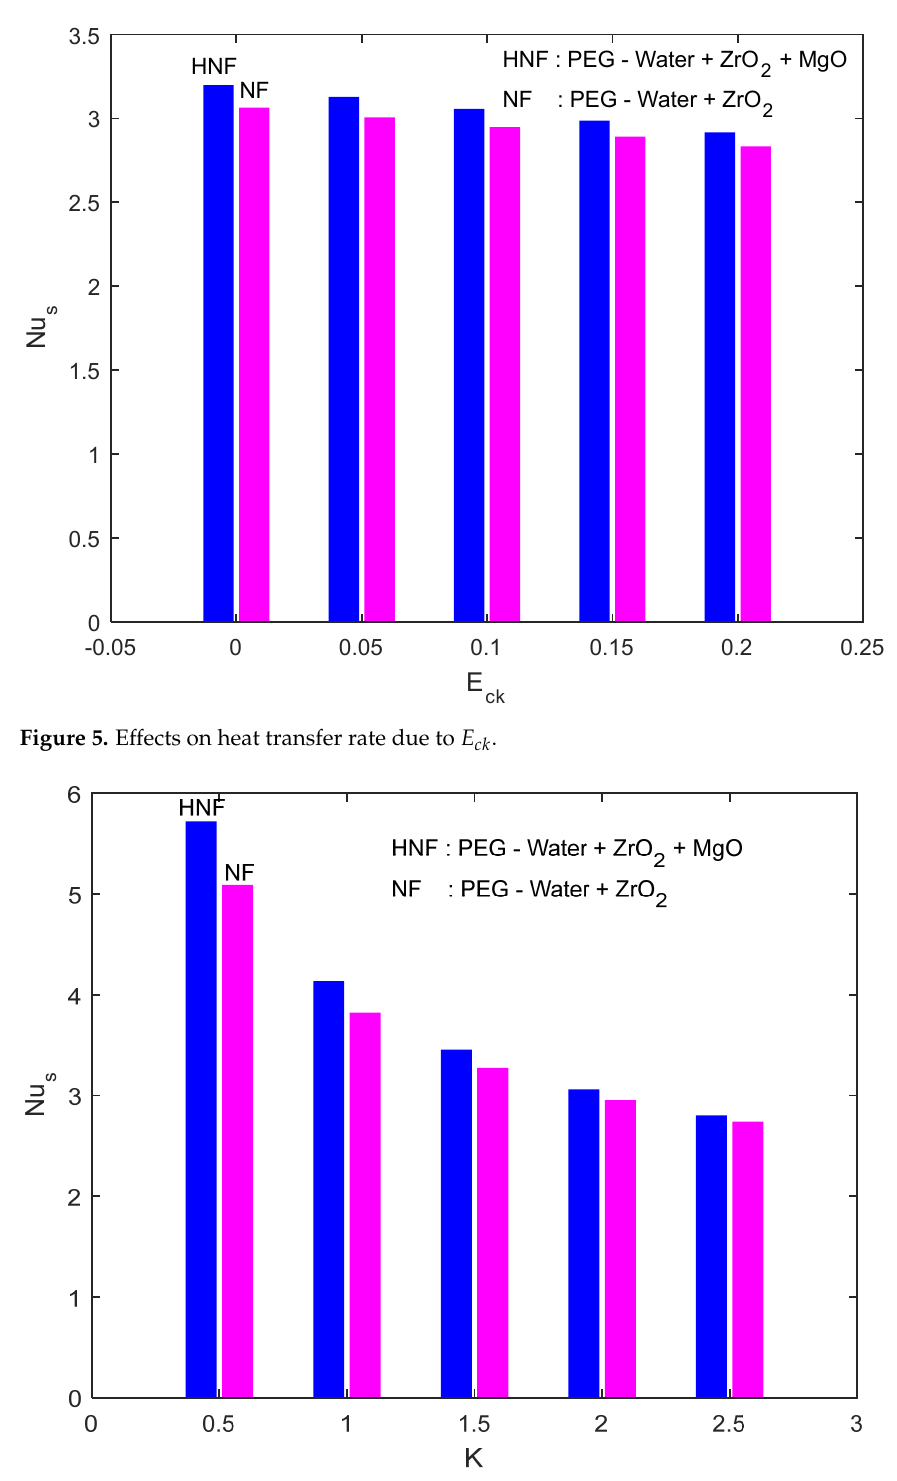
Figure 6. Effects on heat transfer rate due to K .